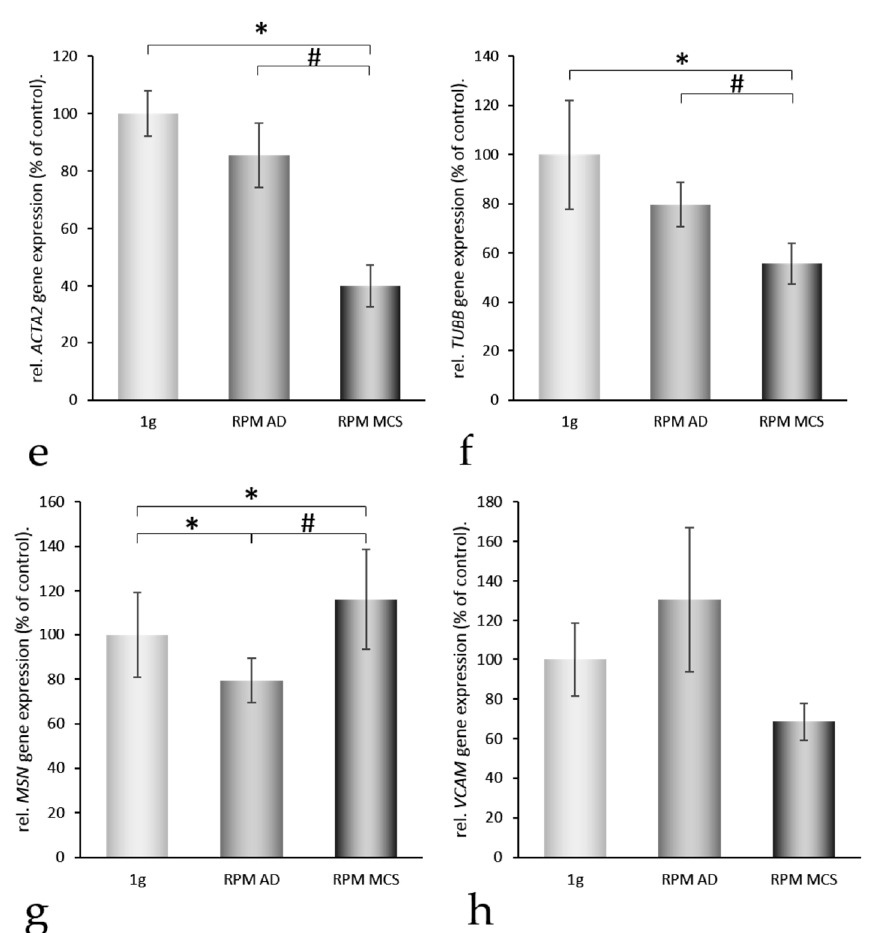
Figure 3. Quantitative real-time PCR of genes of cytoskeletal proteins (Genes of interest I): After 24 h, 1 g -control, RPM-adherent (AD) and RPM-multicellular spheroids (MCS) were analyzed for their ACTB ( a ); KRT8 ( b ); EZR ( c ); RDX ( d ); ACTA2 ( e ); TUBB ( f ); MSN ( g ); and VCAM ( h ) gene expression levels. * = p < 0.05 vs. 1 g ; # = p < 0.05 vs. RPM AD.